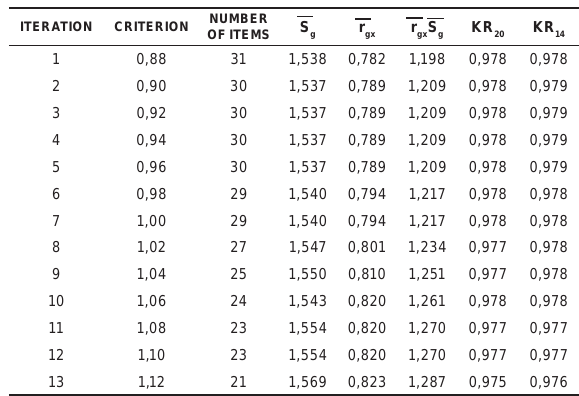
TAbLE 16 Means of Item Statistics (Shortened Scale)